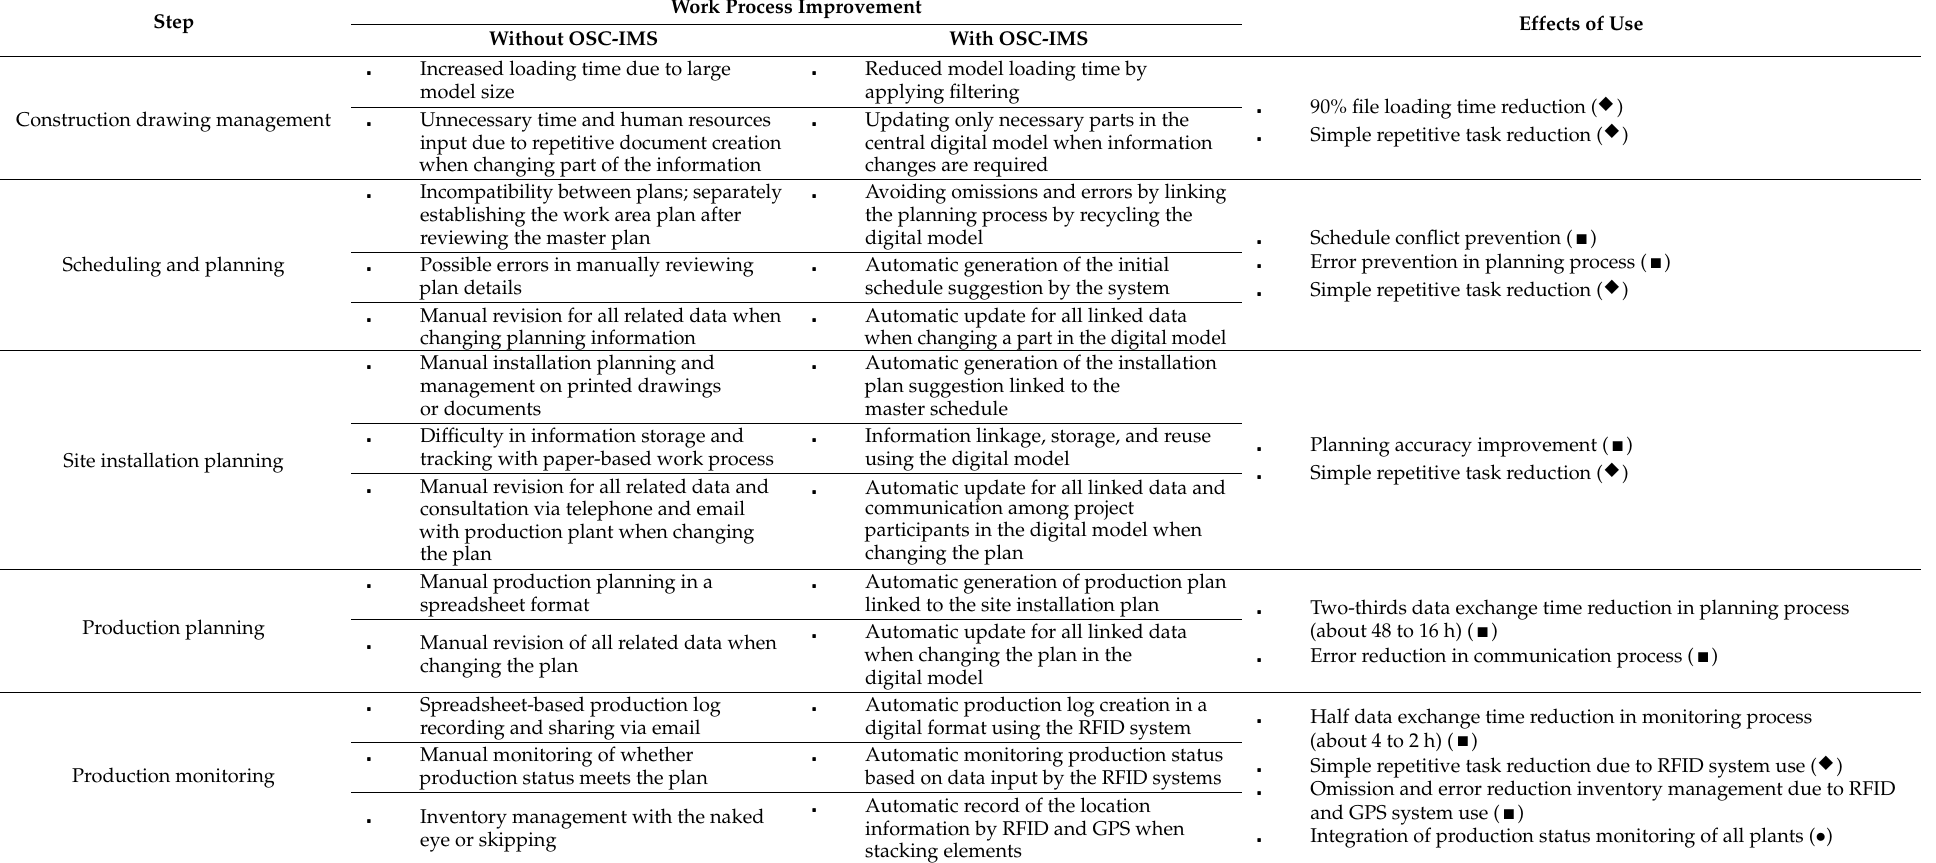
Table 2. Work process improvement and effects based on OSC-IMS